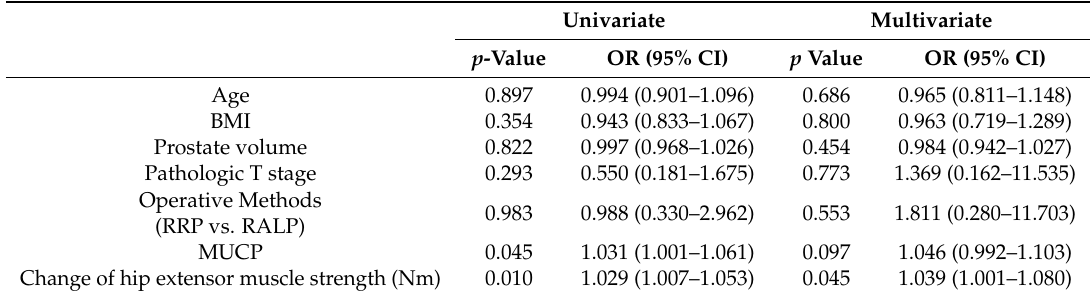
Table 3. Logistic regression analysis to predict post-exercise 12 week continent